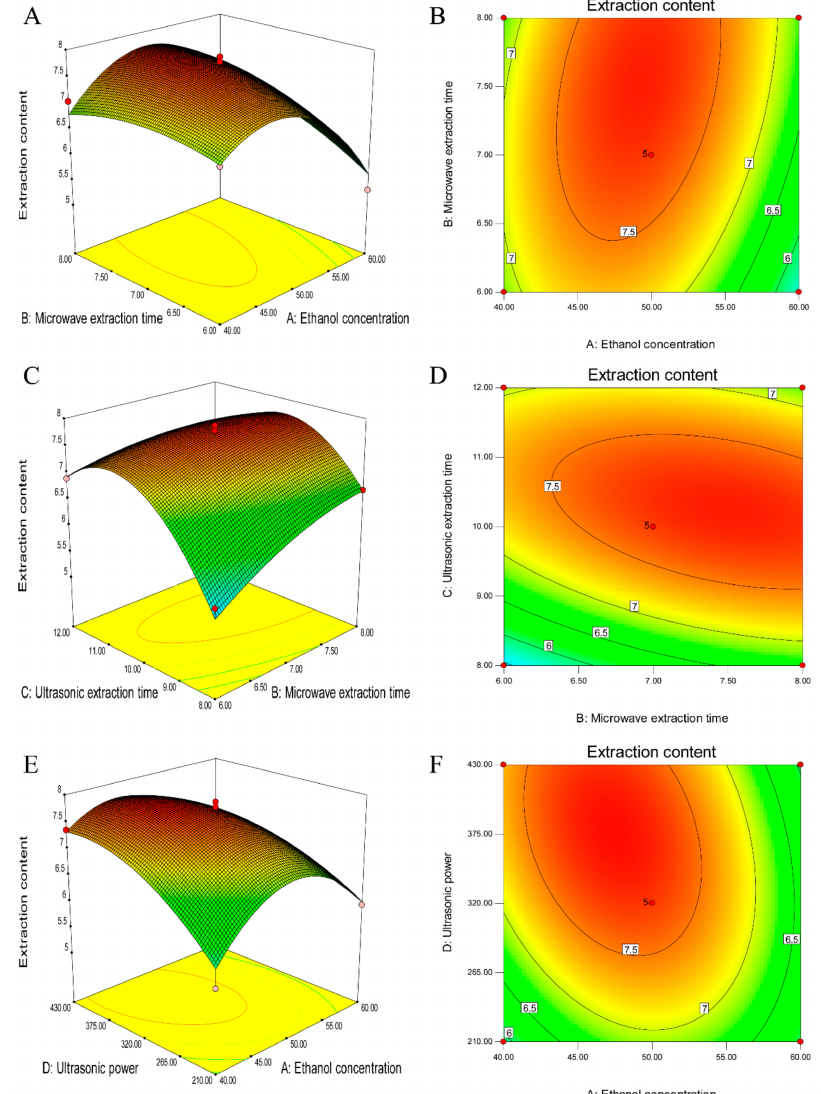
Figure 8. Effect of different microwave treatment times by different solvents on microwave extraction. ( A ) Response surface plot showing the extraction content as a function of microwave extraction time and ethanol concentration; ( B ) Contour plot showing the extraction content as a function of microwave extraction time and ethanol concentration; ( C ) Response surface plot showing the extraction content as a function of ultrasonic extraction time and microwave extraction time; ( D ) Contour plot showing the extraction content as a function of ultrasonic extraction time and microwave extraction time; ( E ) Response surface plot showing the extraction content as a function of ultrasonic power and ethanol concentration; ( F ) Contour plot showing the extraction content as a function of ultrasonic power and ethanol concentration. Figure 8E,F show how the TFC varied with different ethanol concentrations and ultrasonic power levels at a fixed microwave extraction time of 7 min and ultrasonic extraction time of 10 min. With a decrease in the ultrasonic power, the TFC decreased accordingly. An increase in the ethanol concentration from 40% ( v / v ) to 50% ( v / v ) resulted in an increase in the